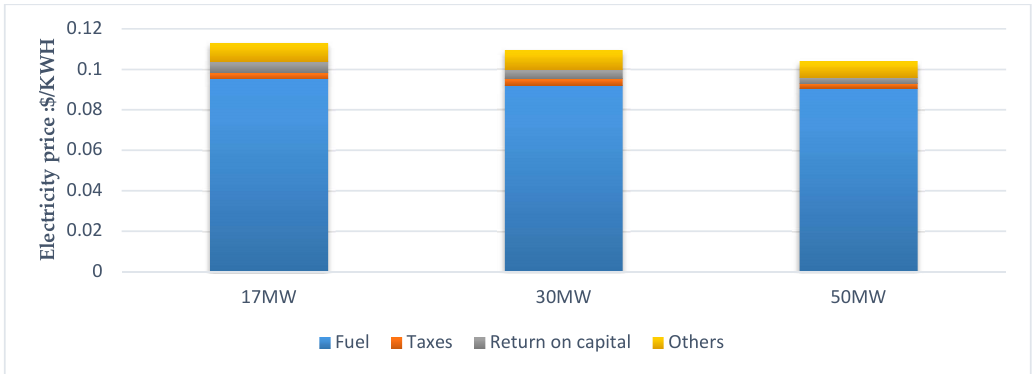
Figure 21. The LCOE components of NGPG units with different installed capacities.